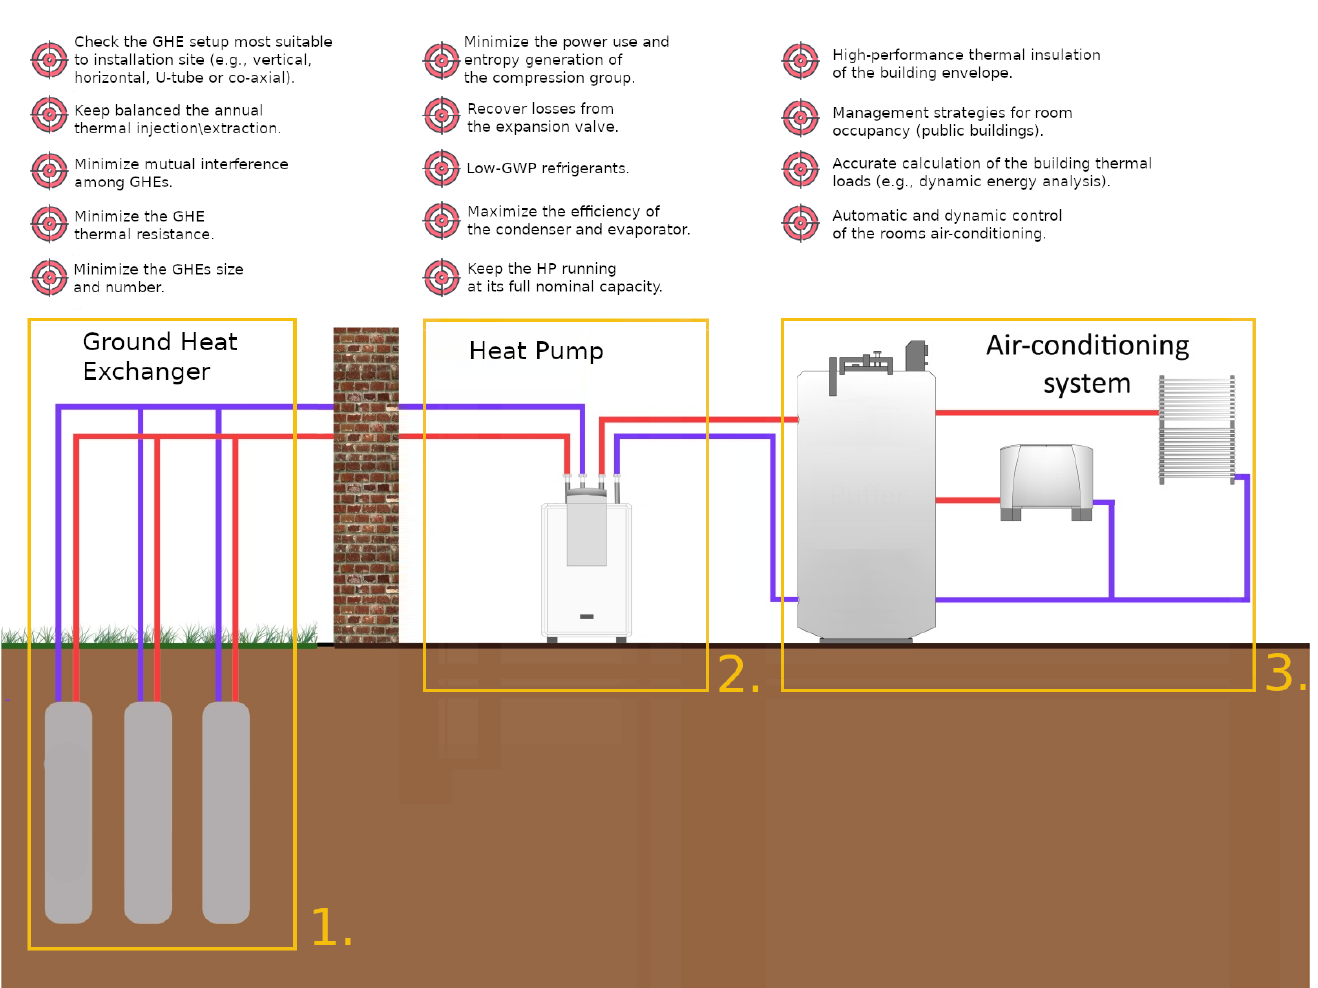
Figure 3. Components of a ground source heat pump : (1) ground heat exchanger; (2) heat pump; (3) the air-conditioning distribution system. Main optimization strategies emerging from literature are shown for each